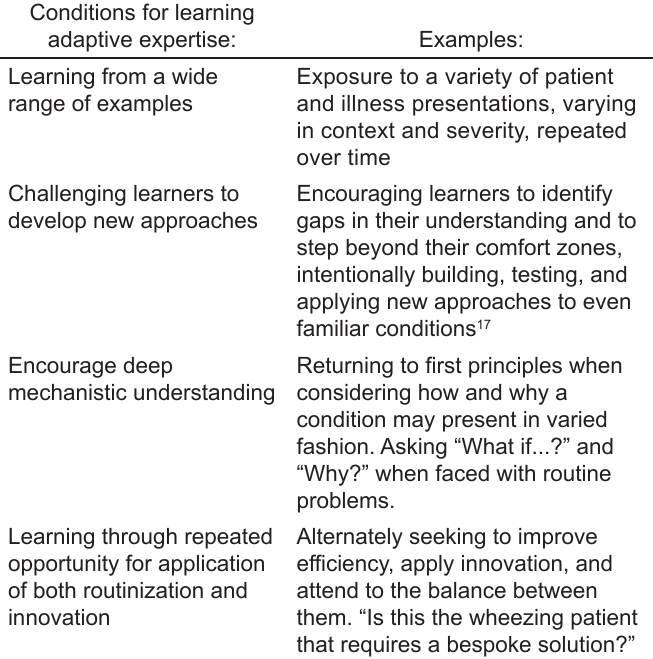
Table 2. Conditions that optimize learning for adaptive expertise.